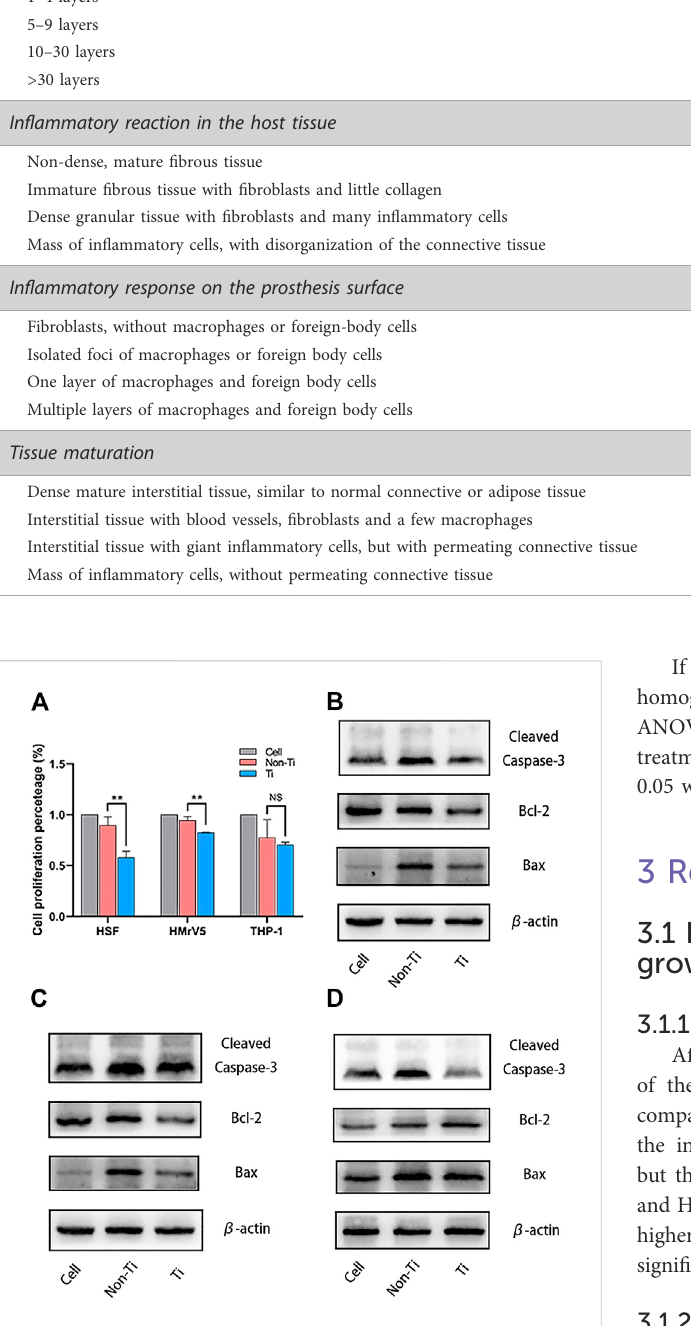
FIGURE 1 Effect of titanium compounds on cell growth. (A) CCK-8 results ofthe3 cellsco-culturedwiththemeshes after48 h; (B) WBresultsof HSF co-culture with the meshes after 48 h; (C) WB results of HMrSV5 co-culture with the meshes after 48 h; (D) WB results of activated THP-1 (M0) co-culture with the meshes after 48